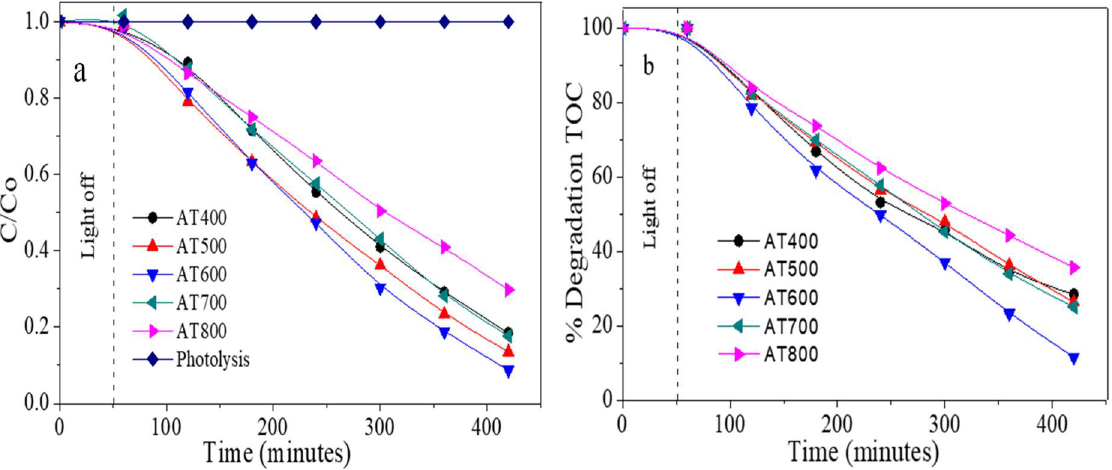
Figure 8. ( a ) C/Co vs. time plots for phenol photodegradation after irradiation with UV-vis light, and ( b ) percentage of degradation on TOC.